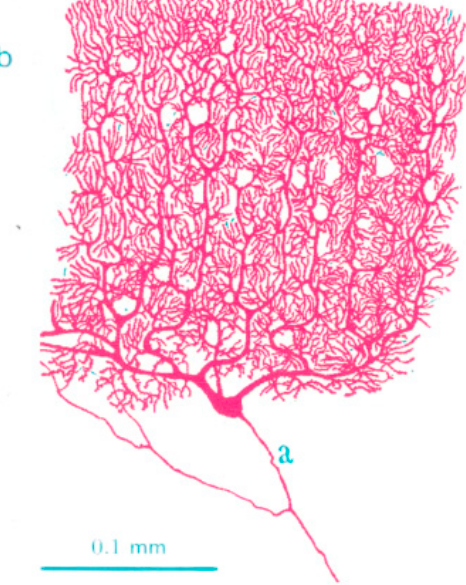
Figure 1. Inputs and outputs of a biological neuron where inputs (dendrites) are denoted as “b” in the figure and outputs (axons) are denoted as “a”. Since one synapse is connected at each input (dendrite), a huge number of synaptic weights are composed at a